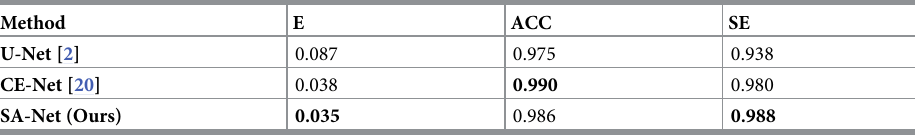
Table 2. Segmentation performance measures for lung image